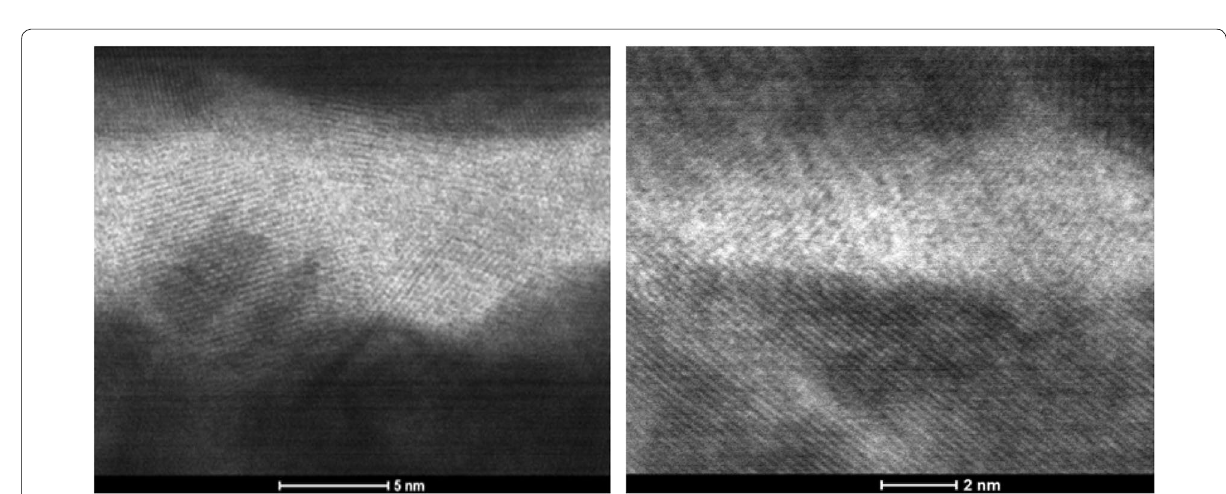
Fig. 4 Interface microstructural features of Sb 2 Te 3 /Au multilayer thin films at the atomic